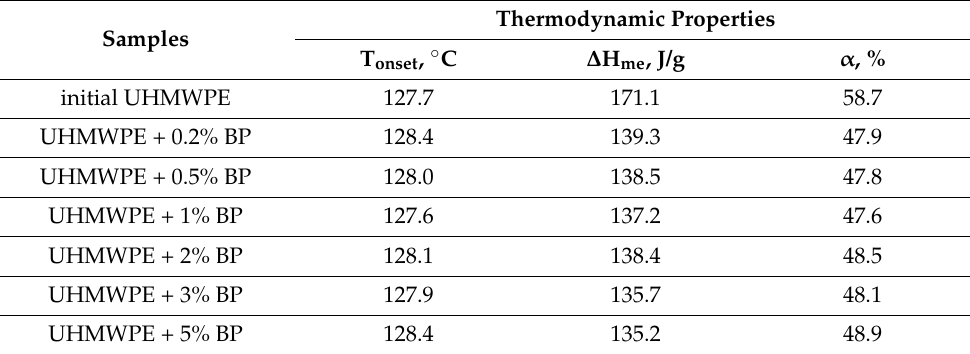
Figure 9. Heating melting function curve of UHMWPE and PCM. Table 2. Melting point, melting enthalpy, and degree of crystallinity of UHMWPE and composite.